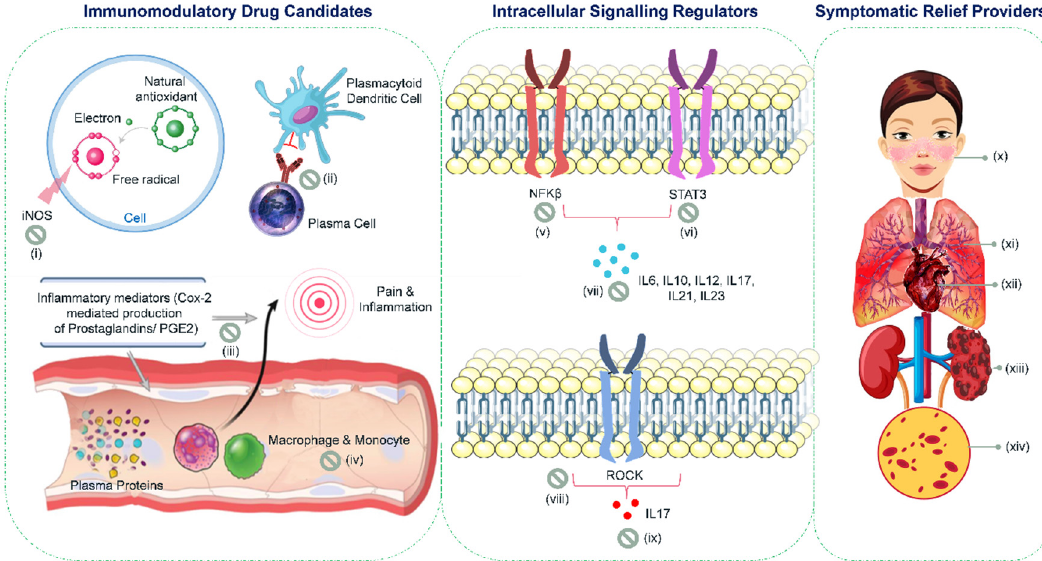
Figure 3. Pharmaco-mechanistic profile of phyto-metabolites in treating systemic lupus erythromatosus. Plant-derived phytoconstituents serve as ( i ) nitric oxide synthase (iNOS) inhibitors and promote the scavenging of free radicals, thereby preventing SLE associated DNA damage (alizarin, asperuloside, α -amyrin, β -amyrin, andrographolide, angelic acid, cadinol, isophytol, β -phellandrene, galic